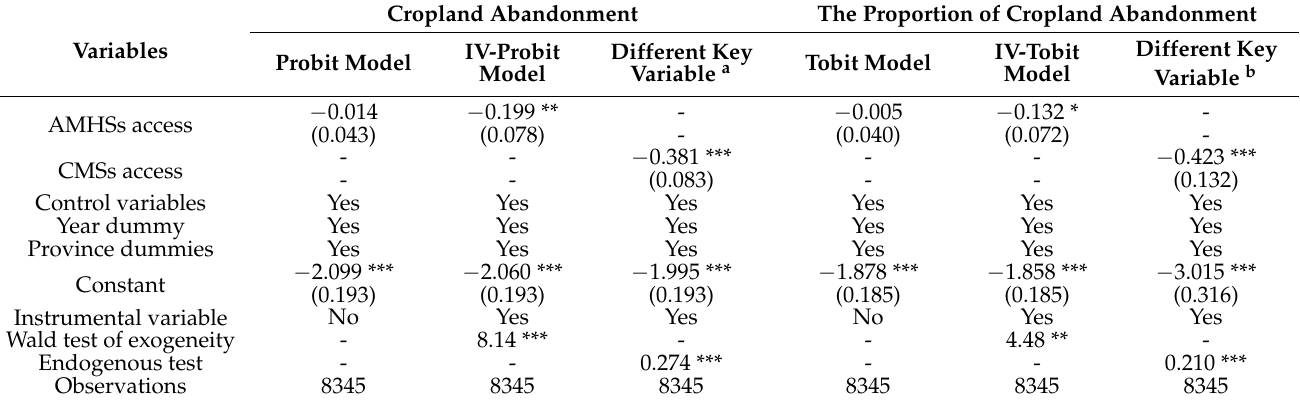
Table 3. Robustness check models estimation